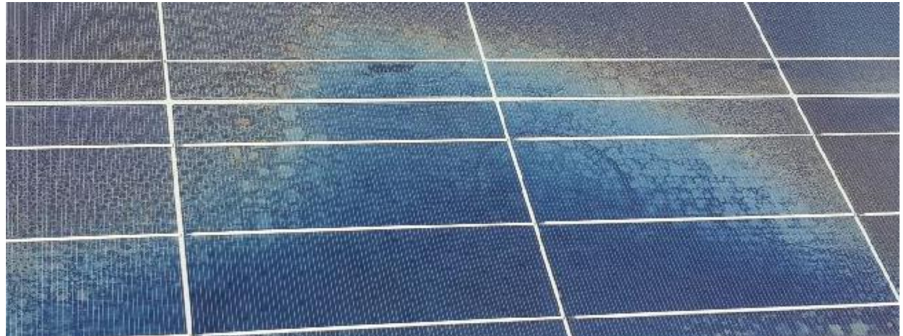
Figure 11. Bubbles in a PV module.